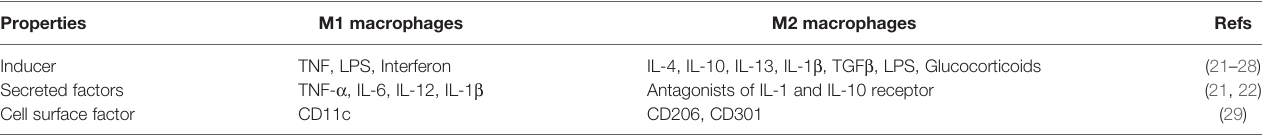
TABLE 1 | Properties of adipose tissue